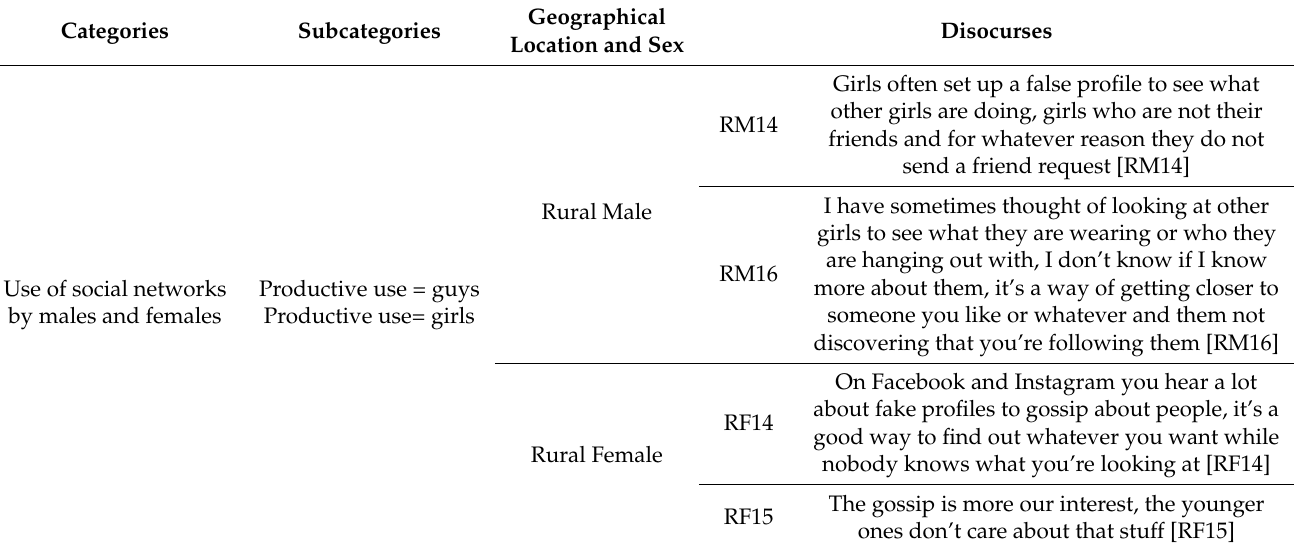
Table 5. Use of social networks to engage in gossip. Different Female,